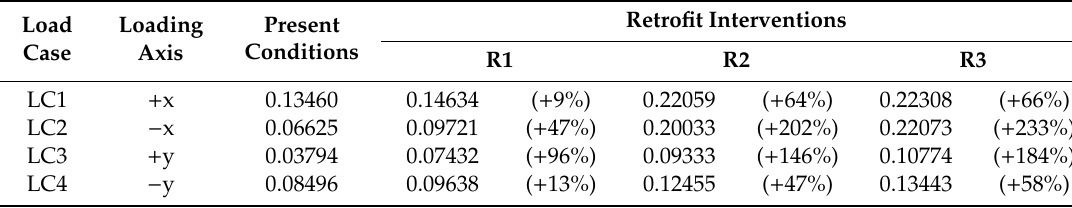
Table 4. Collapse load multipliers for the four structural configurations under investigation. The percentage increases respective to the present conditions are reported in